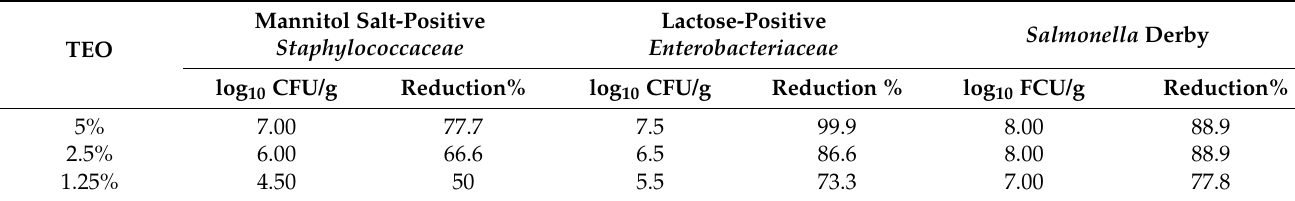
Table 5. Microbial growth of each strain expressed as log 10 CFU/g, and percent reduction in growth (%) compared to the positive control after 24 h treatment with TEO at different